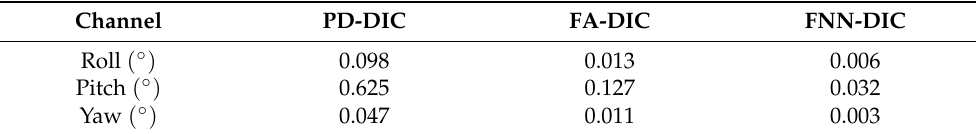
Figure 13. Yaw angle tracking results under atmospheric disturbance: ( a ) Yaw angle tracking curve, and ( b ) tracking error curve. Table 5. Maximum tracking error of attitude angle under atmospheric turbulence.